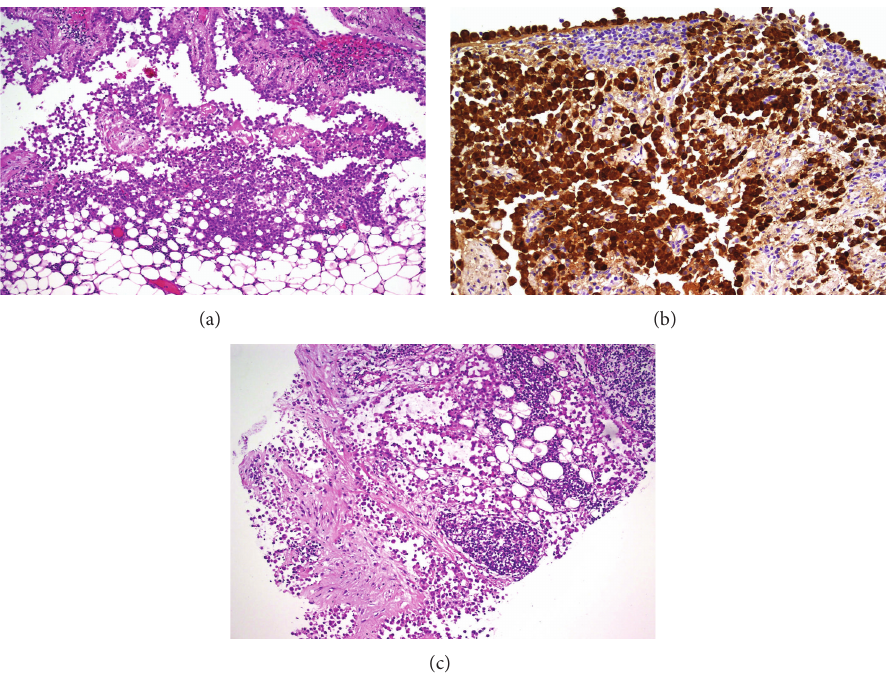
Figure 4: (a) The H&E staining ((a) × 200) of the pleural tumor. (b) The immunohistochemistry ((b) × 200) of the pleural tumor. (c) The abdominal tumor (H&E ×